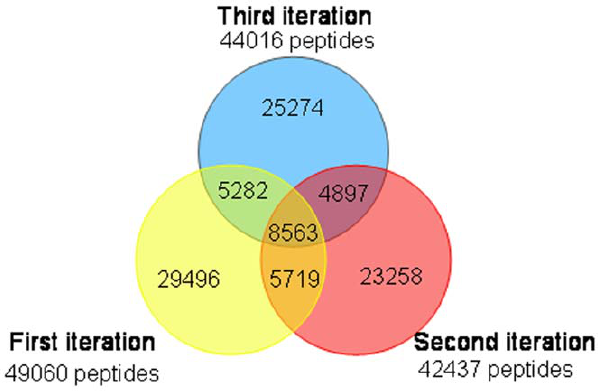
Figure 1. Number of unique peptides identified in one or more iterations, sum of all sets. On average, the second iteration added 78% new peptides to those identified after the first run, while the third iteration added 36% more peptides. Within a given set, about 12% of the peptides were common to any two successive iterations; however, only 3 to 6% of the peptides were identified in all three